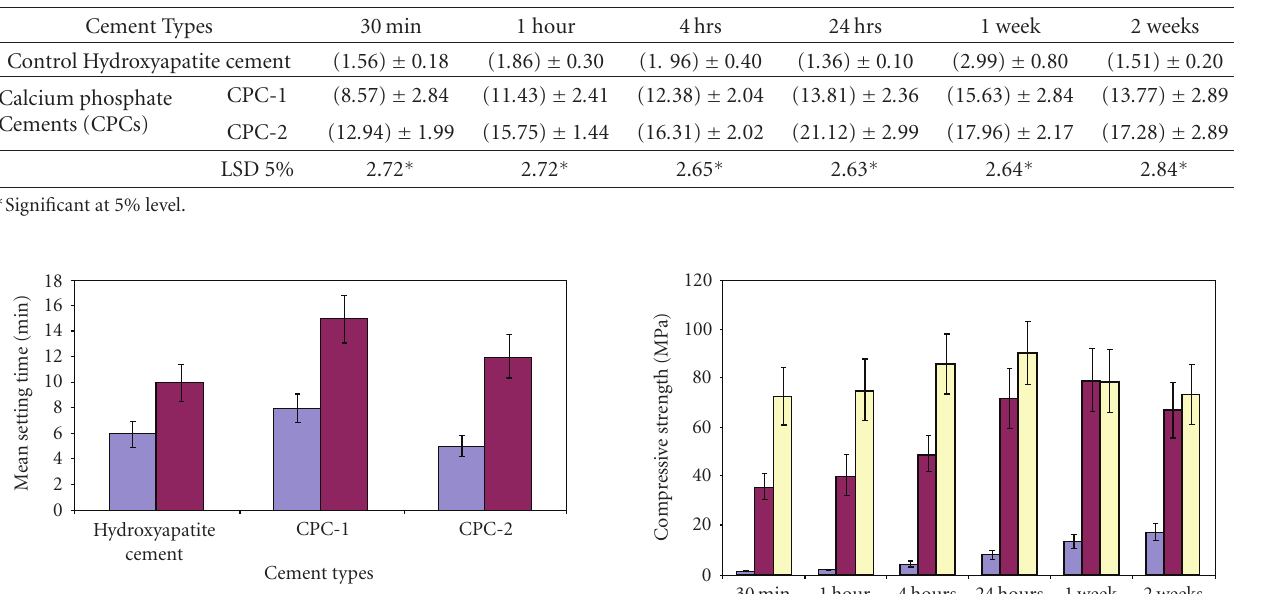
Table 4: Mean diametral tensile strength and standard deviation of hydroxyapatite cement and the two polymeric calcium phosphate cements (CPCs) [the value in parenthesis are inMPa].